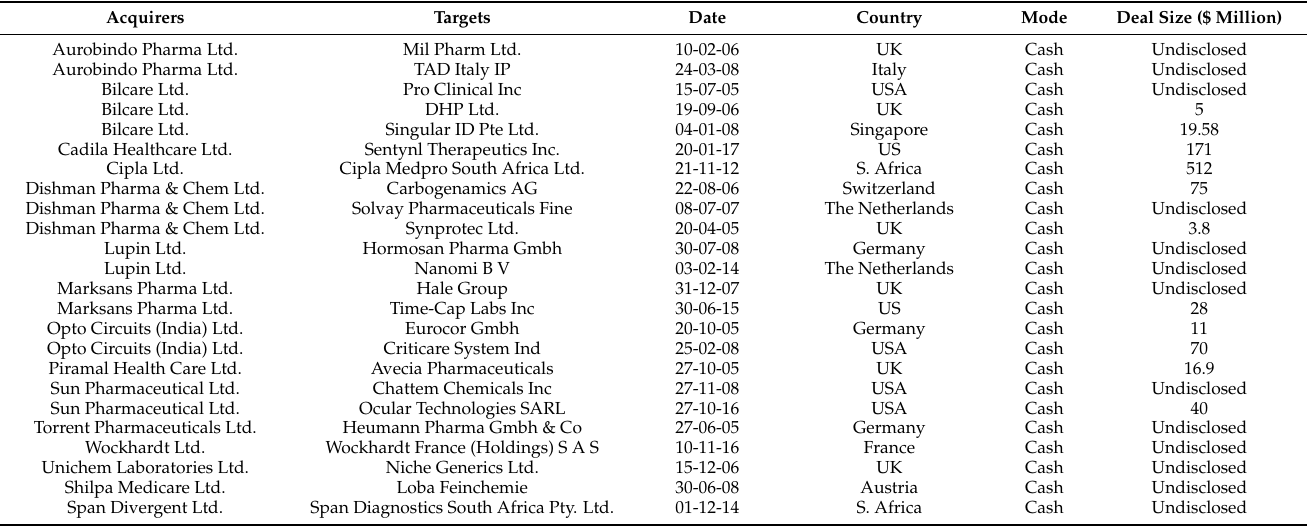
Table A1. Cross-border acquisitions considered in the